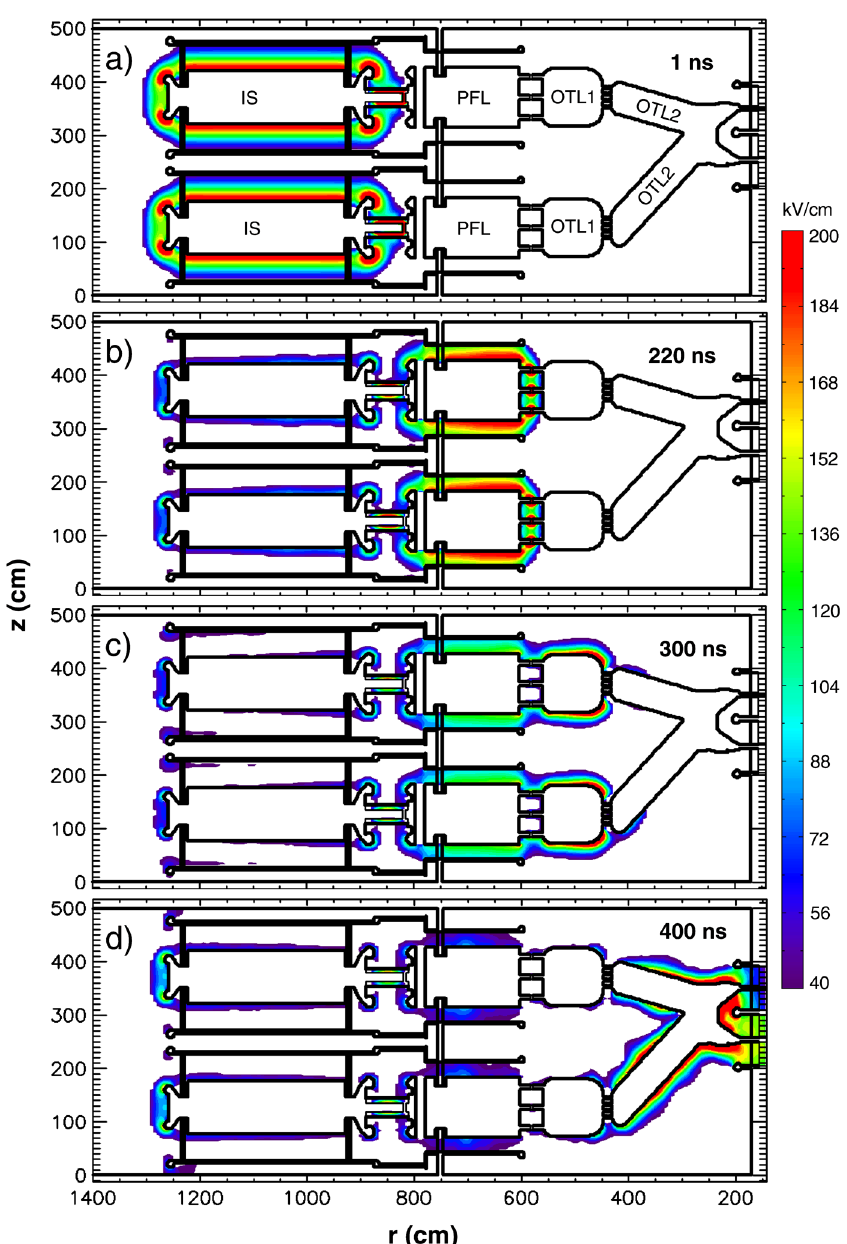
FIG. 7. (Color) Electric-field magnitude in the LSP ZR simulation at times 1, 220, 300, and 400 ns in the (cid:2) ¼ 0 plane.